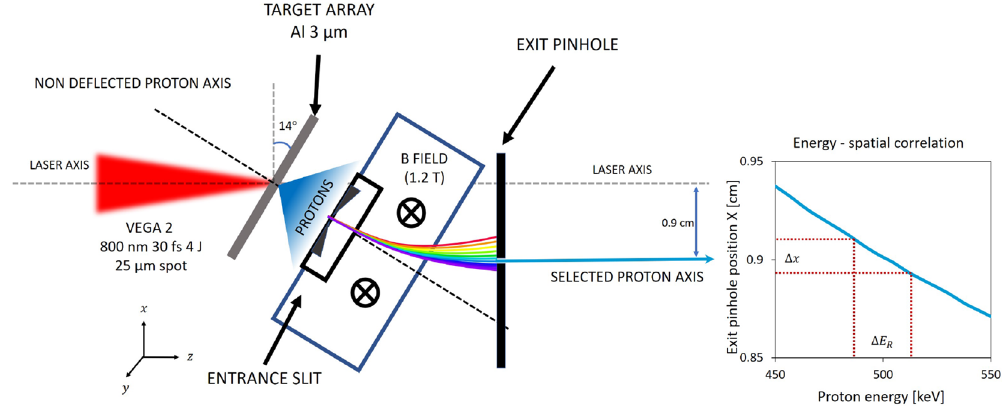
Figure 8. Scheme of the energy selection of 0.5 MeV proton beam with the energy spatial correlation.